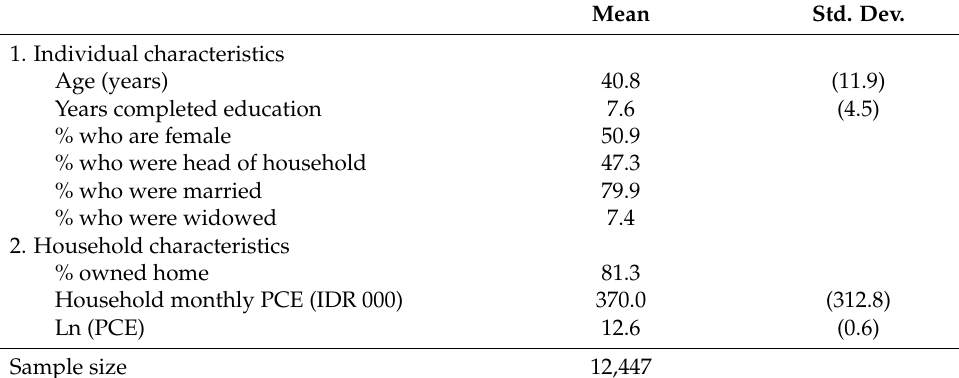
Table 4. Characteristics of respondents measured at pre-tsunami baseline.